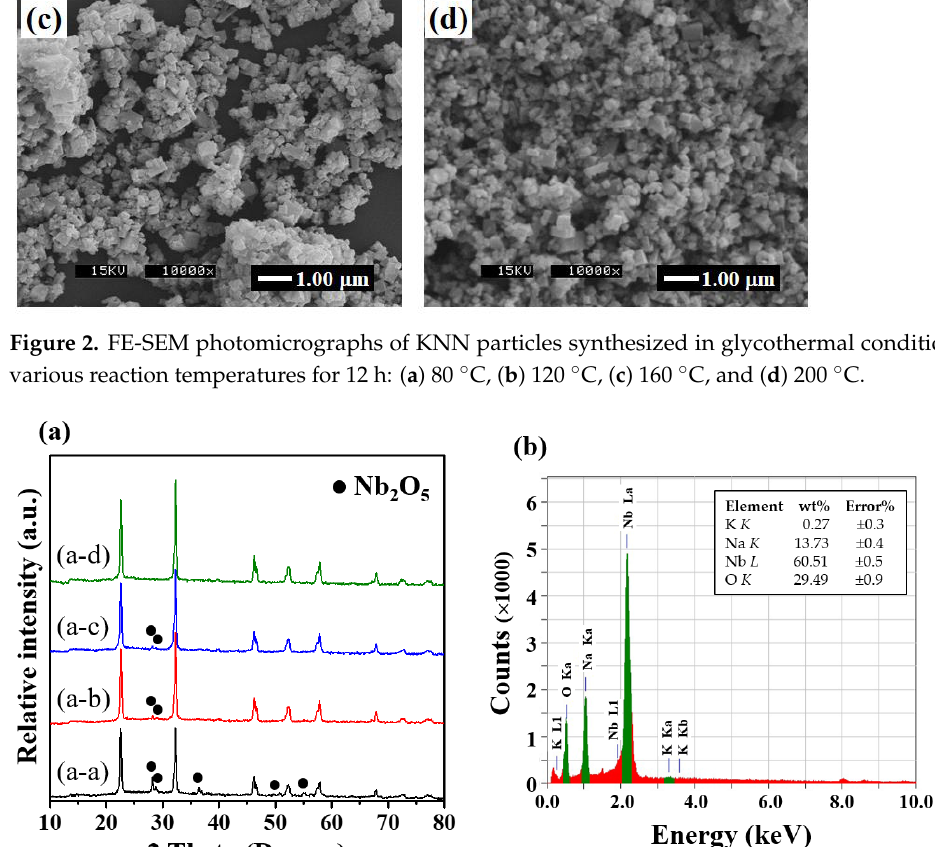
Figure 2. FE-SEM photomicrographs of KNN particles synthesized in glycothermal conditions at various reaction temperatures for 12 h: ( a ) 80 °C, ( b ) 120 °C, ( c ) 160 °C, and ( d ) 200 °C.